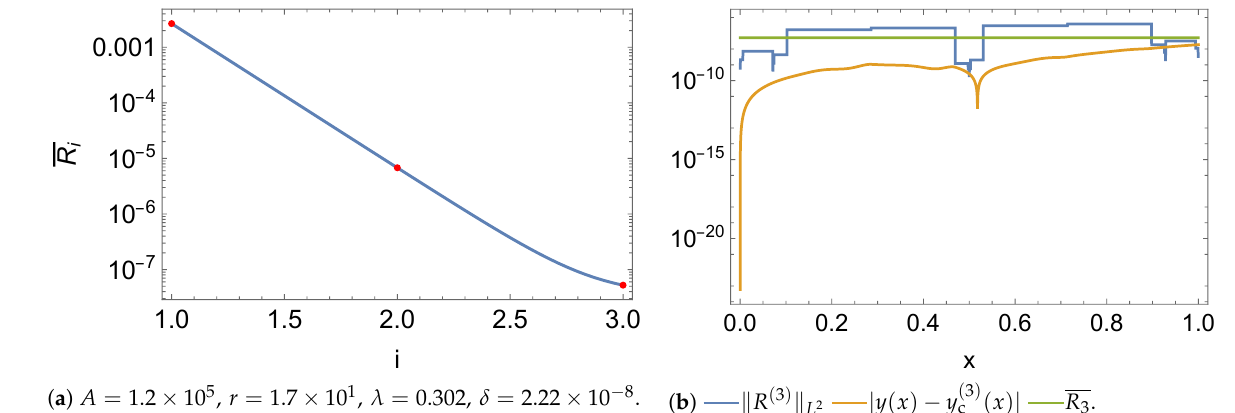
Figure 4. ( a ) Fitting the upper bound (24) with the set R . ( b ) Visualization of the residual, absolute local approximation error and the mean value.